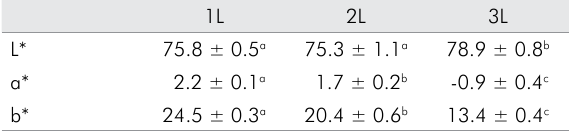
Table 1. Means and standard deviations of L*, a*, and b* values of layered resin